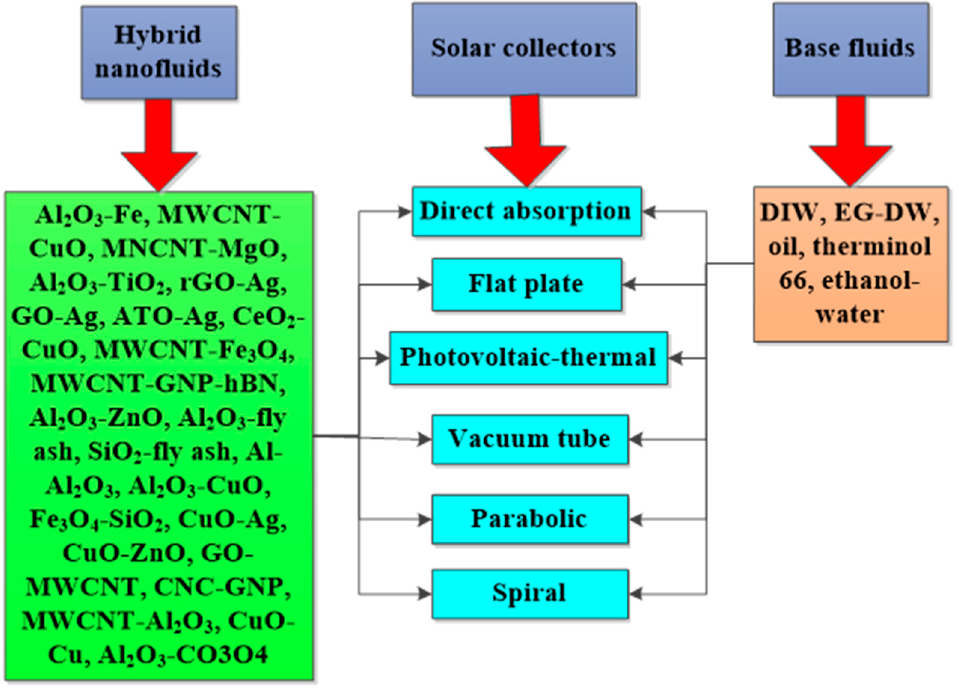
Figure 17. Hybrid nanofluids deployed in various solar collectors.